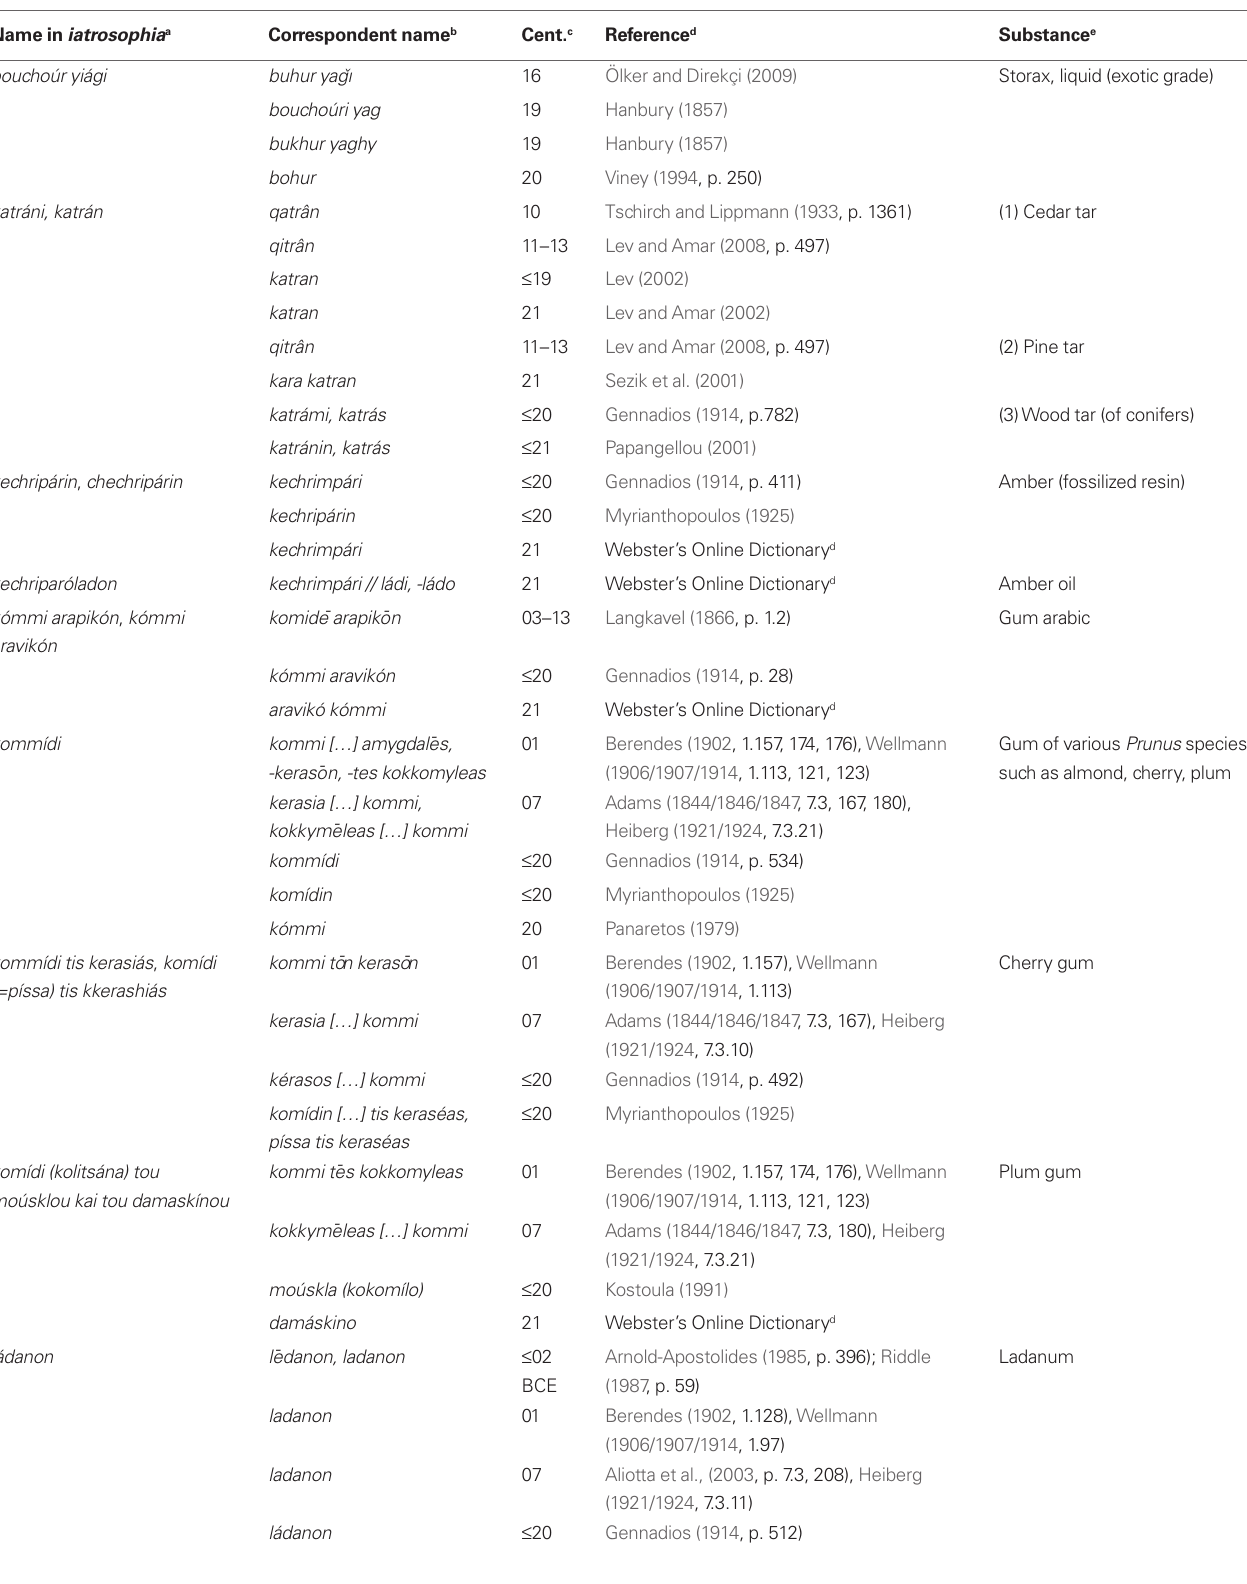
Table 2 | identification of the substance names mentioned in the iatrosophia. Name in iatrosophia